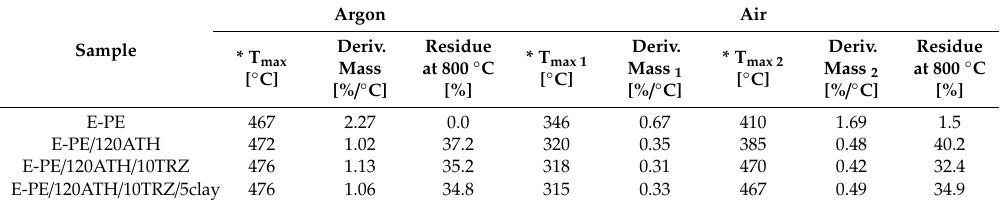
Figure 6. TG and dTG curves of E-PE, E-PE / 120ATH, E-PE / 120ATH / 10TRZ and E-PE / 120ATH / 10TRZ / 5clay composites. ( A , B ) curves in argon, and ( C , D ) curves in air atmospheres. Table 2. Thermal data of polymer E-PE, E-PE / 120ATH, E-PE / 120ATH / 10TRZ and E-PE / 120ATH / 10TRZ / 5clay composites by thermogravimetric analyses.